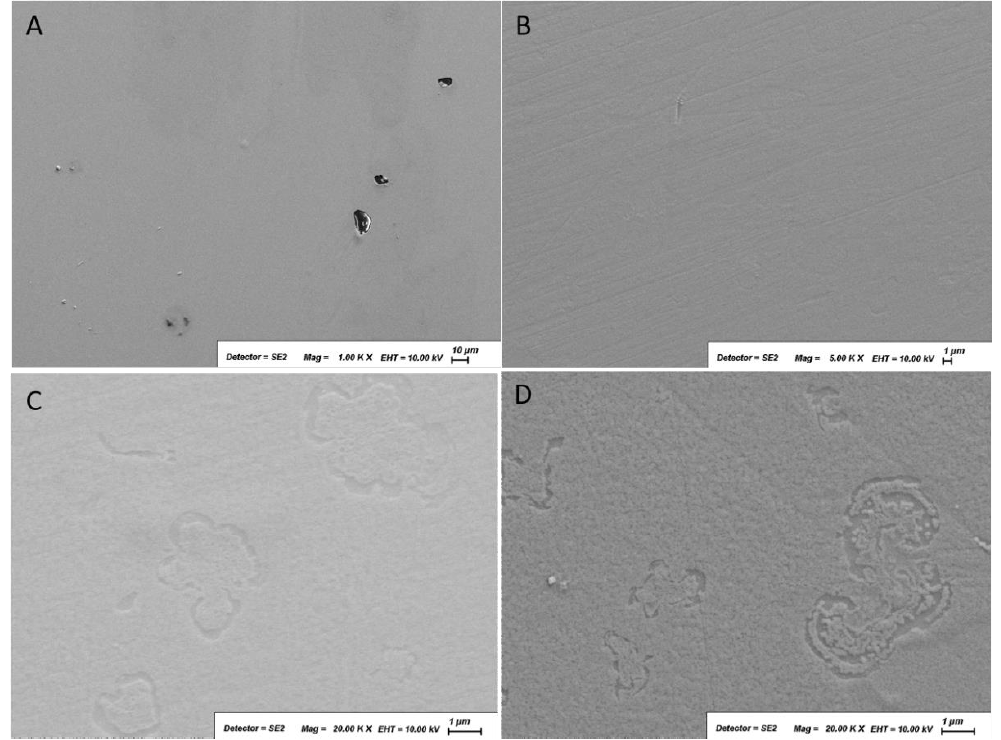
Figure 3. ( A ) The smooth homogenous surface of S6; ( B ) homogenous distribution of the film in sample S7 with an indication of orientation (linear marks); ( C ) secondary electron image of sample S2 showing “flower-like” structures; ( D ) secondary electron image of sample S5 showing “flower-like” structures.